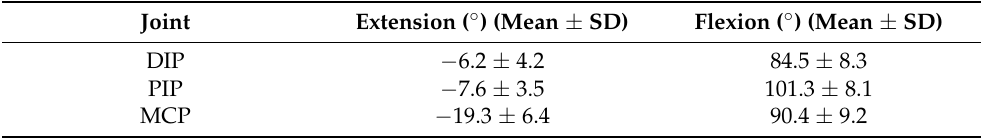
Table 2. Mean range of motion (ROM) for finger